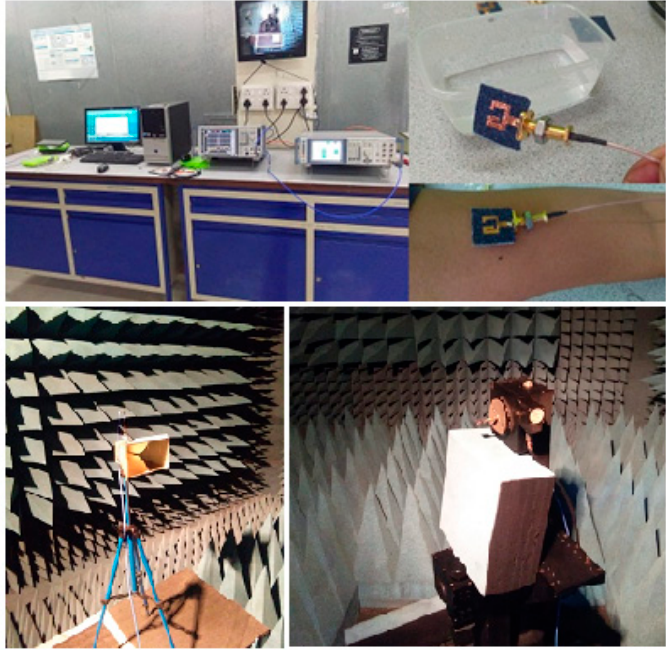
Figure 8. Testing environment of the proposed antenna.